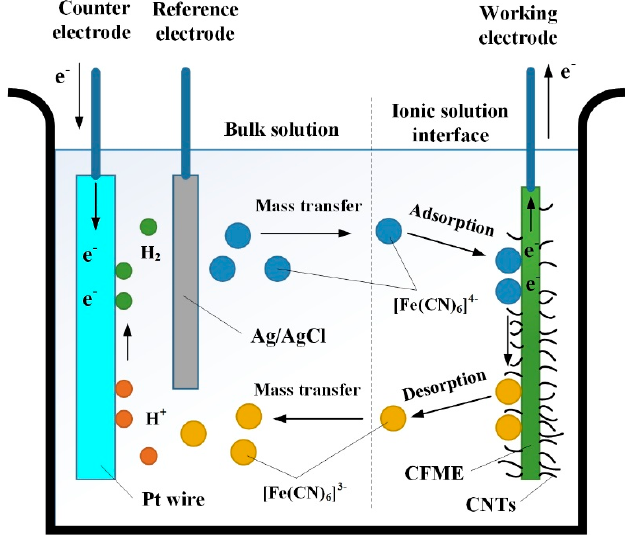
Figure 2. Schematic diagram of the electrochemical reaction under a three-electrode system in K 4 Fe(CN) 6 aqueous solution.